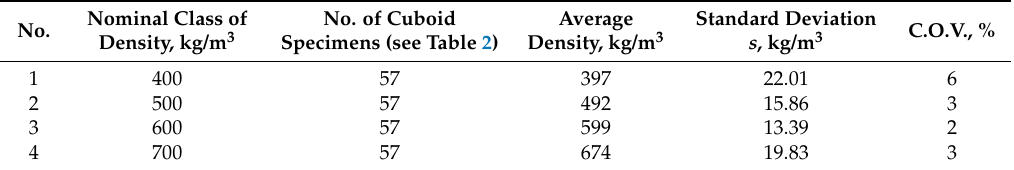
Table 3. Test results for AAC